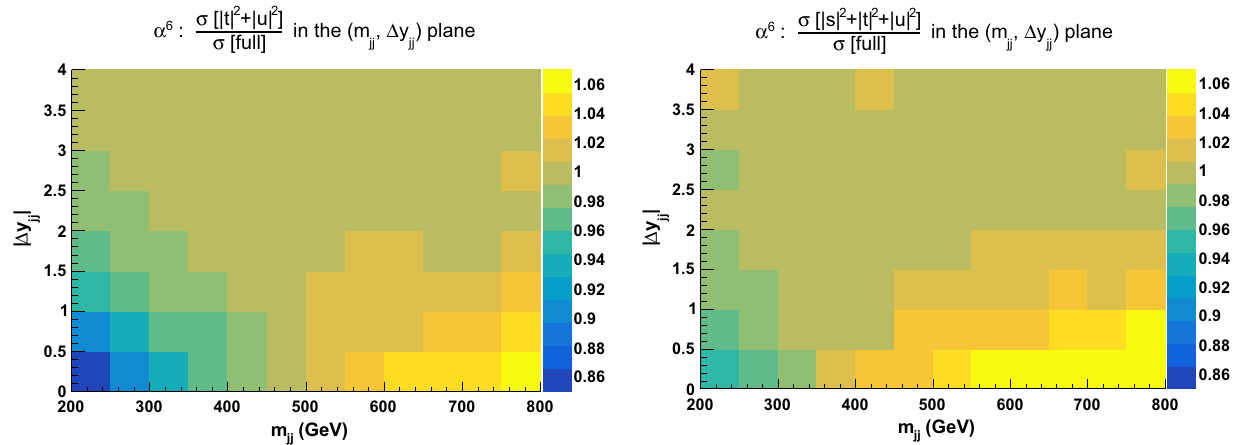
Fig. 4 Ratios for double-differential distributions in the variables m jj and | Δ y jj | at LO i.e. order O (α 6 ) of approximated squared amplitudes over the full matrix element. The approximated squared amplitudes are